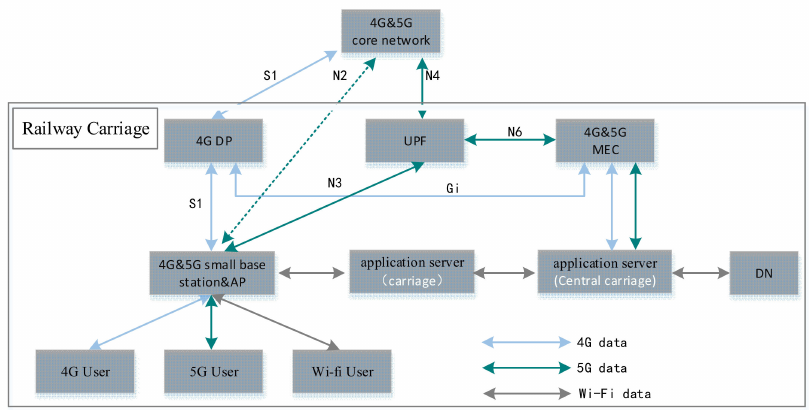
Figure 6. The architecture of UPF combined with